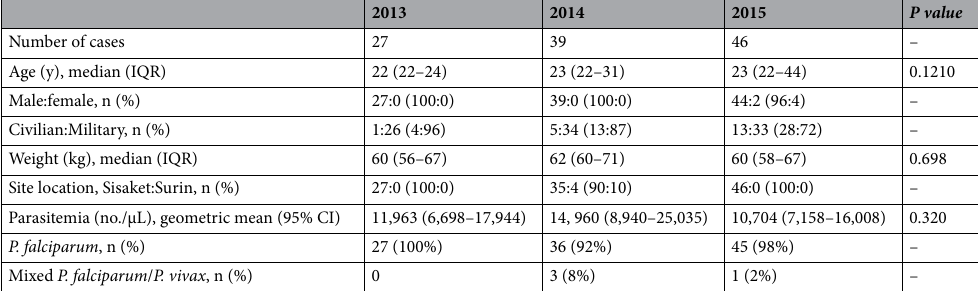
Table 1. Patient and parasitological characteristics of 112 participants. P values calculated by the Kruskal– Wallis